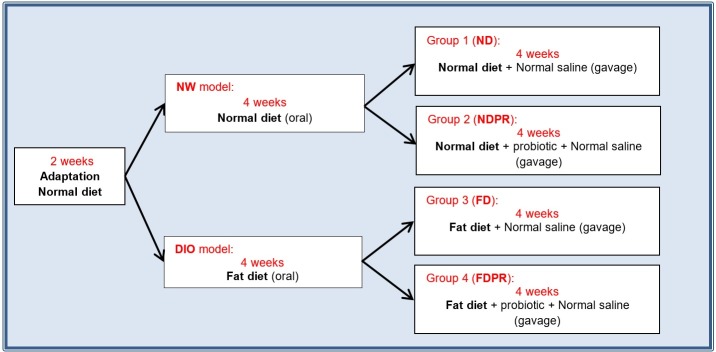
Study design and groups.